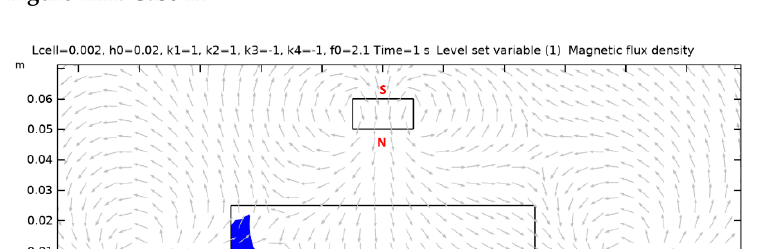
Figure A11. Case 12.